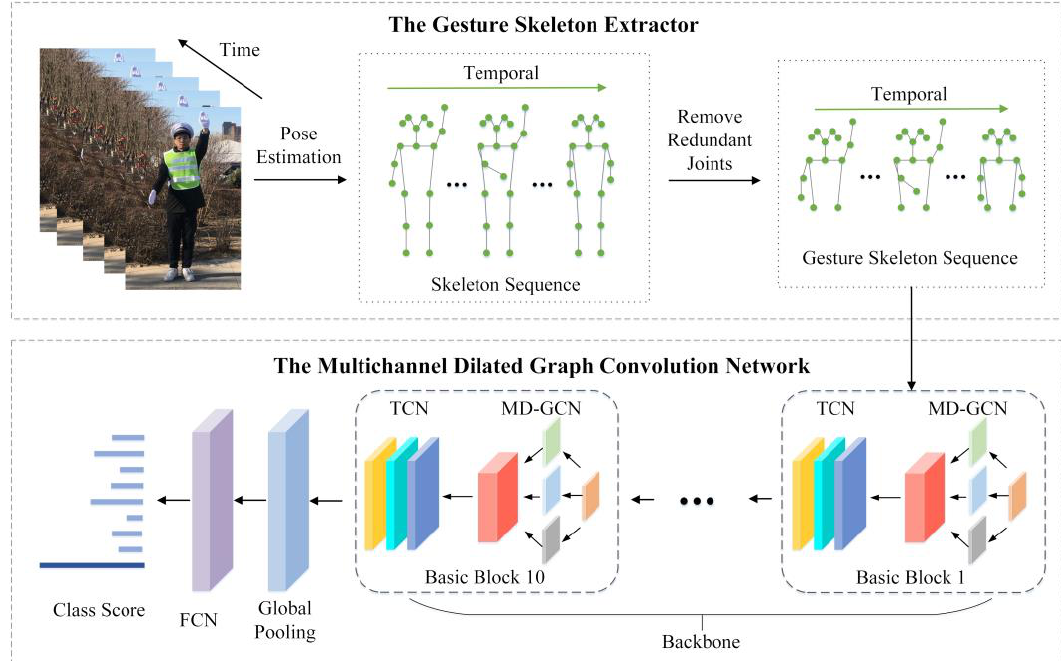
Figure 1. Overview of the proposed gesture recognition method. The FCN means the fully connected network, the TCN means the temporal convolution network.